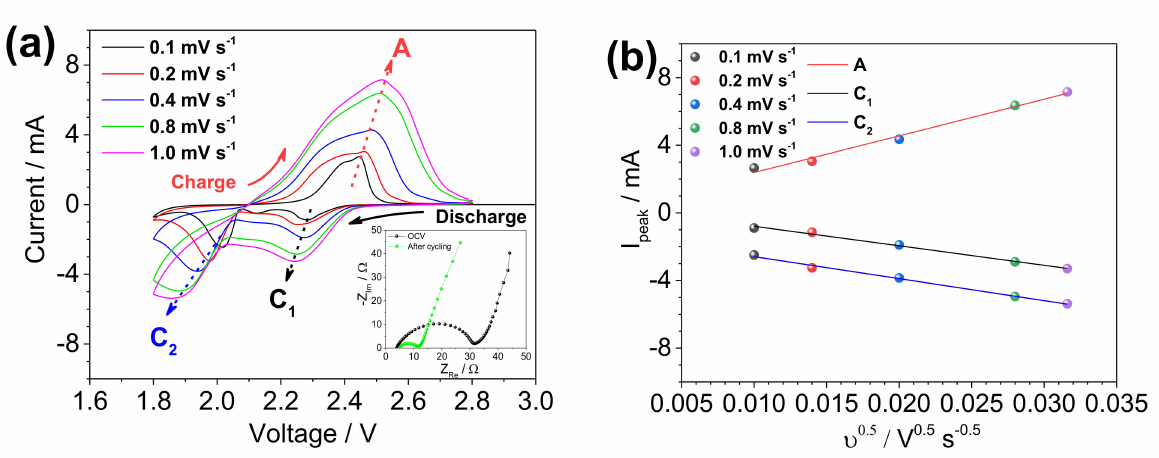
Figure 2. ( a ) Cyclic voltammograms recorded at di ff erent scan rates (from 0.1 to 1.0 mV · s –1 ). Electrochemical impedance spectroscopy (EIS) spectra before (black) and after (green) the first cycle, recorded at 0.1 mV · s − 1 , are shown in the inset. ( b ) Variation in the peak current with the square root of the scan rate (Randles–Sevcik